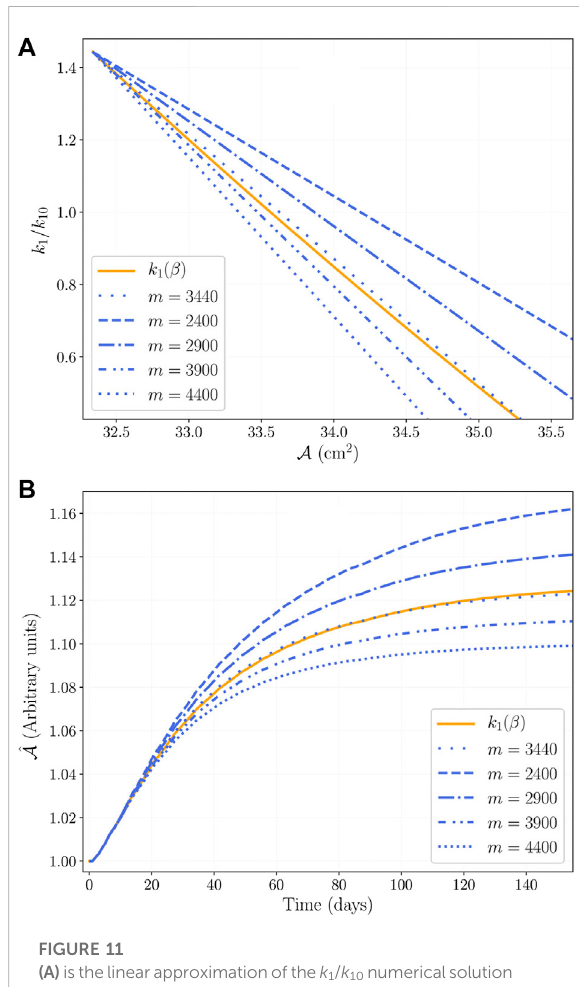
FIGURE 11 (A) isthelinearapproximationofthe k 1 / k 10 numericalsolution of Figure 7, the variation of the slope represents different protein synthesis responses. (B) Evolution of the CSA for the different variations presented in (A)